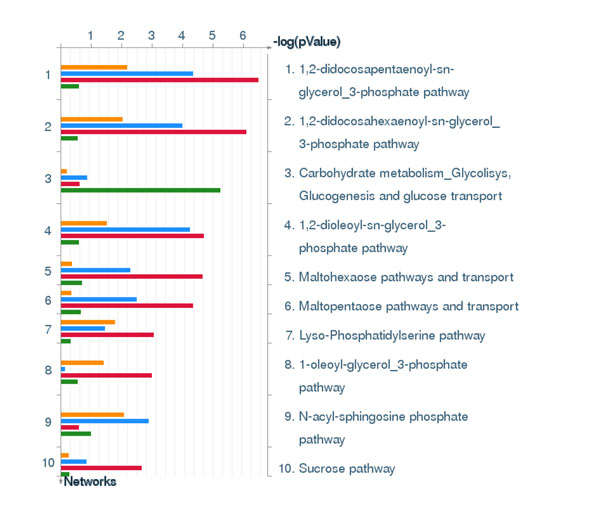
GeneGo metabolic networks analysis. Sorting of the GO term enrichment is done by p-values. The p-value is estimated by GeneGo MetaCore 'Statistically Significant Networks' method (see Figure 7 for details).